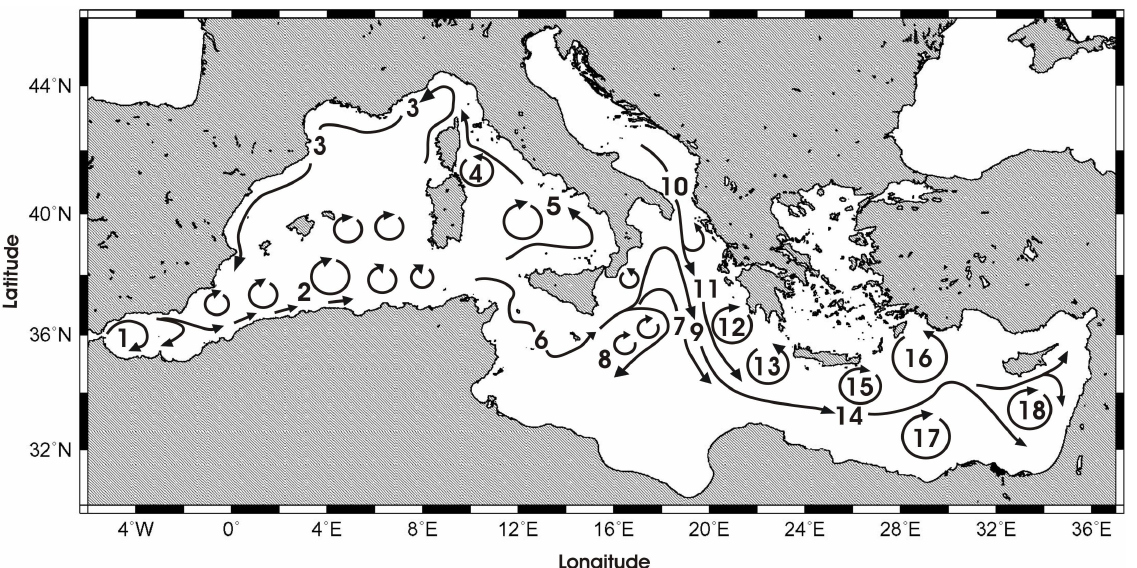
Fig. 1. Upper layer circulation and main features in the Mediterranean Sea (adapted from Millot, 1999; Malanotte-Rizzoli et al., 1997; Robinson and Golnaraghi, 1994): 1-Western Alboran Gyre, 2-Algerian Current, 3-Liguro-Provenc¸o-Catalan Current, 4-Bonifacio Gyre, 5- Tyrrhenian Current, 6-Atlantic-Ionian Stream, 7-Modified Atlantic Water, 8-Ionian Anticyclones, 9-Mid Ionian Jet, 10-Adriatic Surface Wa- ter, 11-Ionian Surface Water, 12-Pelops Anticyclone, 13-Cretan Cyclone, 14-Mid-Mediterranean Jet, 15-Ierapetra Anticyclone, 16-Rhodes Gyre, 17-Mersa-Matruh Gyre, 18-Shikmona